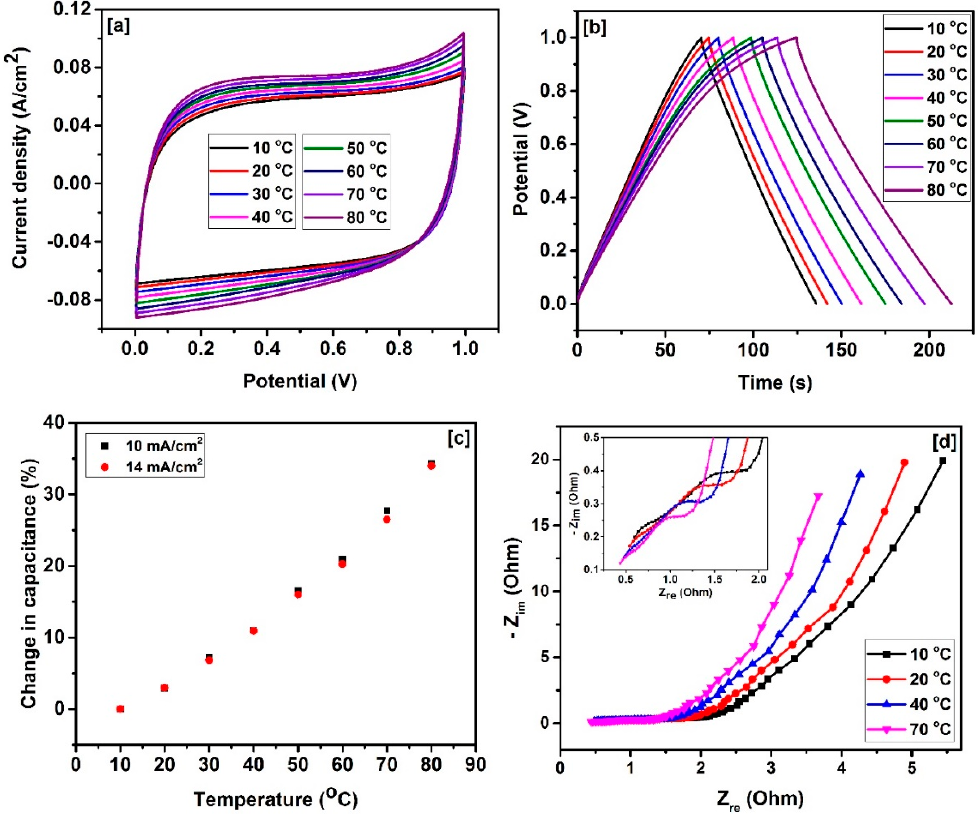
Figure 7. ( a ) CV curves for various temperatures at the scan rate of 100 mV/s. ( b ) GCD profiles for various temperatures at the current density of 10 mA/cm 2 . ( c ) % change of the specific capacitance against temperature and ( d ) Nyquist plots of selected temperatures with inset displaying magnification at higher frequency region for an OPAC-1 supercapacitor in 3 M KOH.